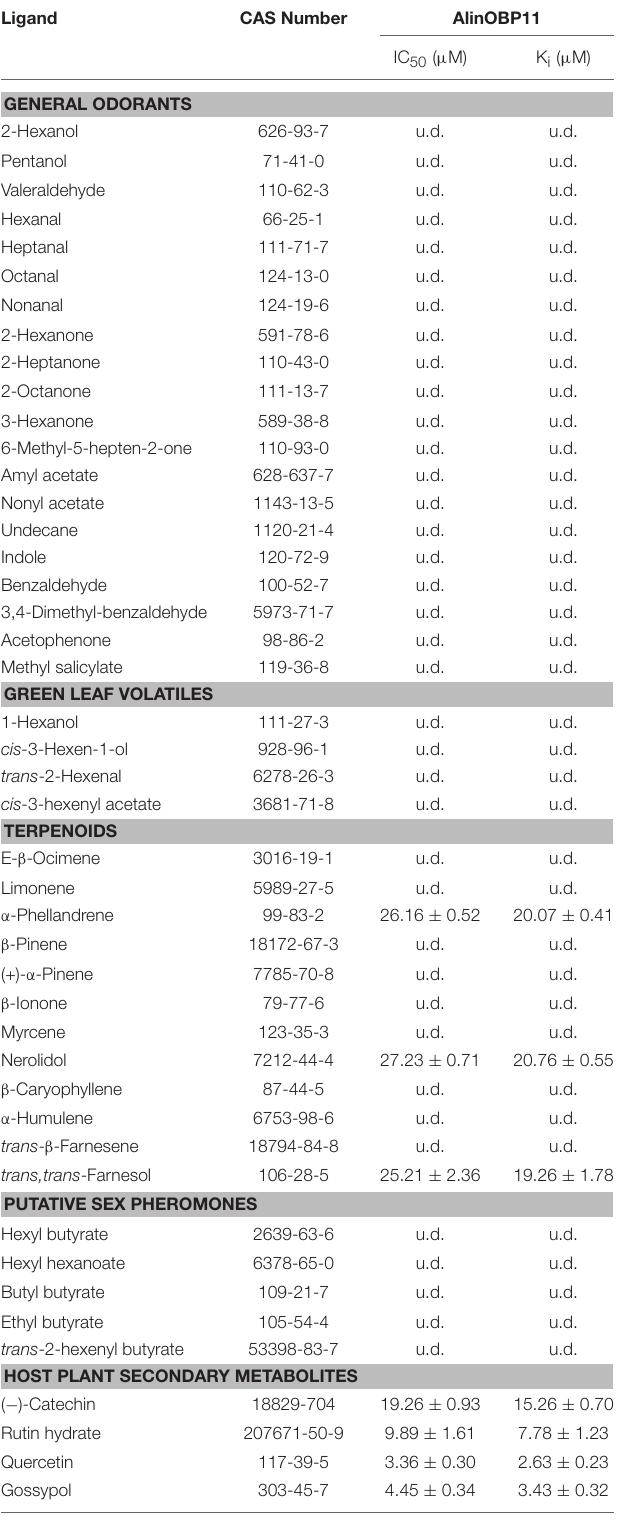
TABLE 1 | Binding affinities of all of the selected compounds to the recombinant AlinOBP11 protein. Ligand CAS Number AlinOBP11